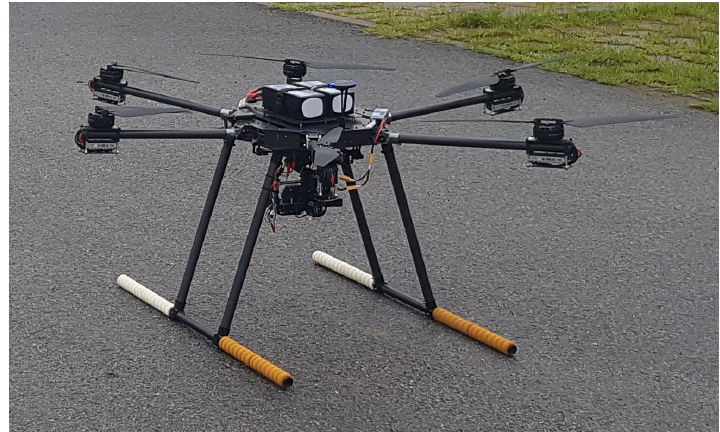
Figure 2. Physical structure of the